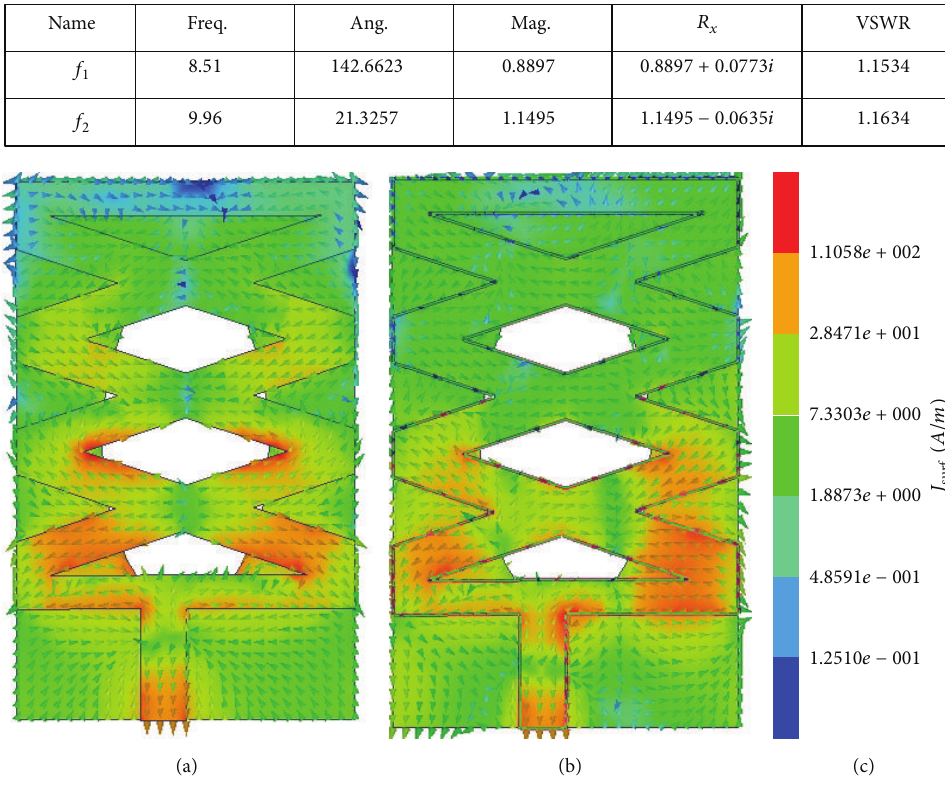
Figure 11: Surface current distributions at (a) 8.51GHz and (b) 9.96 GHz (c)